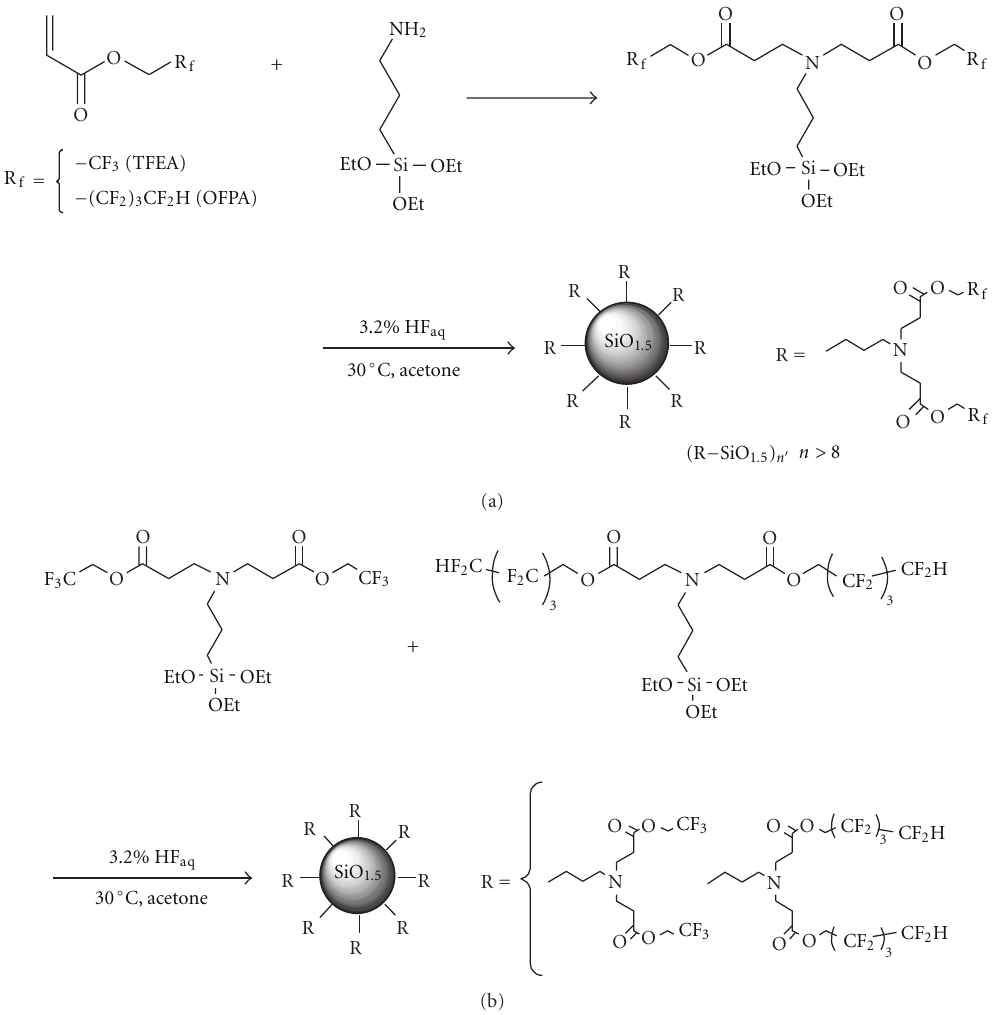
Figure 8: Synthetic routes for fluorinated silsesquioxane-based hybrids obtained via (a) hydrolytic condensation of triethoxysilane precursors derived from fluoroalkyl acrylates, and (b) hydrolytic cocondensation of TFEA-based and OFPA-based triethoxysilane precursors.